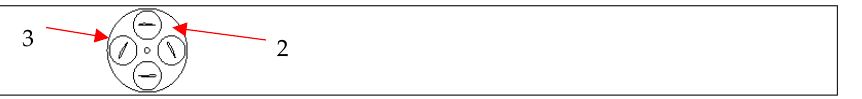
Figure 14. Geometry of cycloidal rotor used in CFD. 1—Duct; 2—Inner domain with shaft; 3—Blade domains.